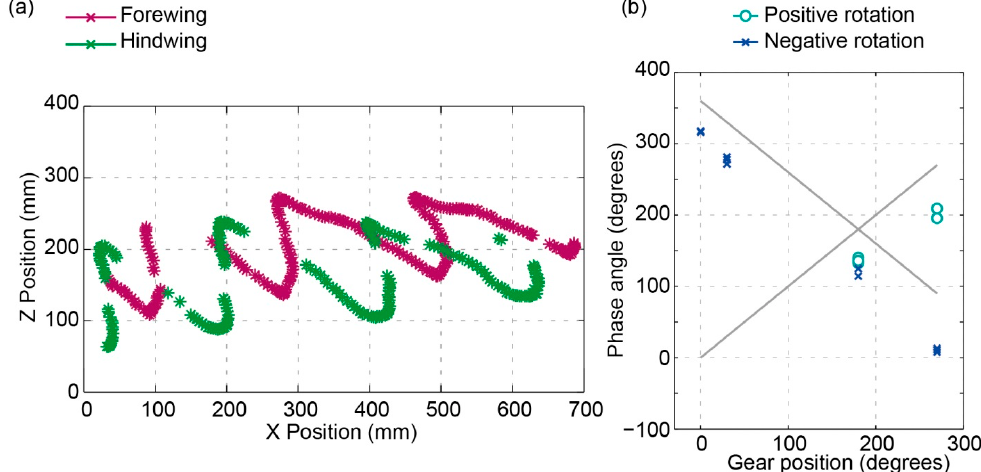
Figure 8. ( a ) Trajectories of the wing tips of the ornithopter, which is shown in Figure 7; ( b ) relationship between the set gear position and the phase angle.